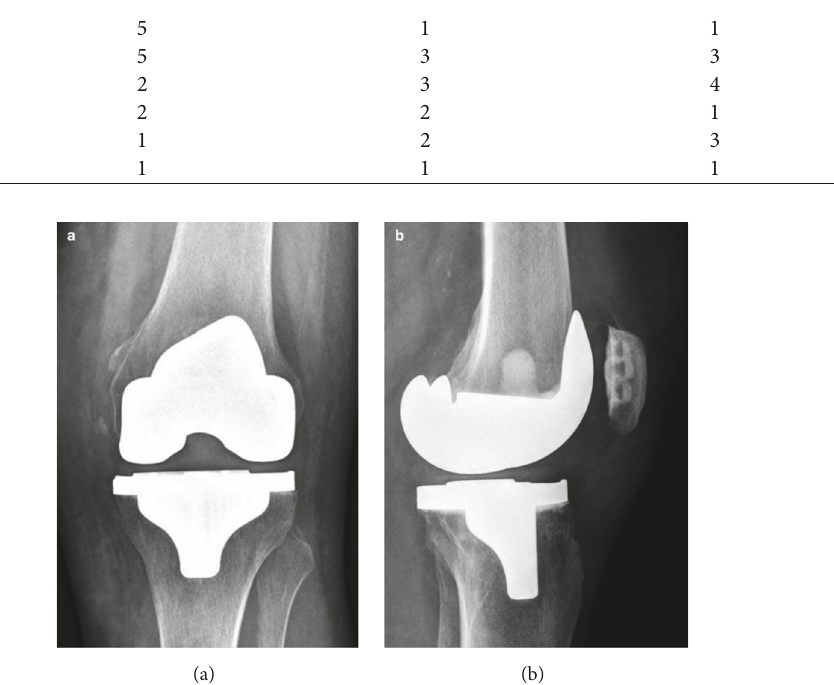
Table 2: Characteristics of nonbiodegradable metallic biomaterials (grades ranged from 5, excellent score, to 1, poor score) [22, 23, 28, 57]. Characteristics